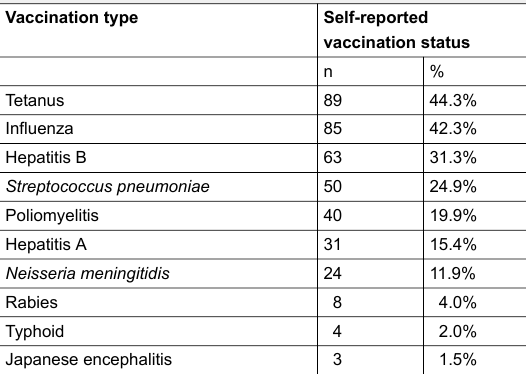
Table 4 : Self-reported vaccination status in 201 travel episodes among patients after allogeneic haematopoietic stem cell